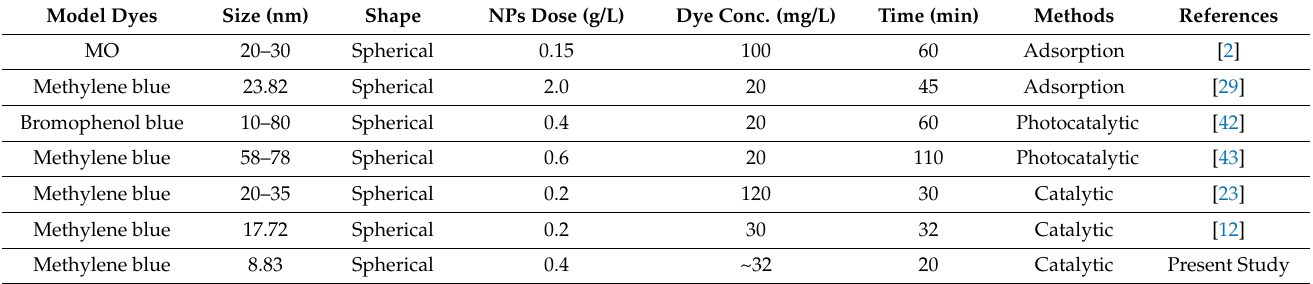
Table 2. Comparison of catalytic efficacies of Fe 3 O 4 NPs for the reduction of harmful dyes [12]. Model